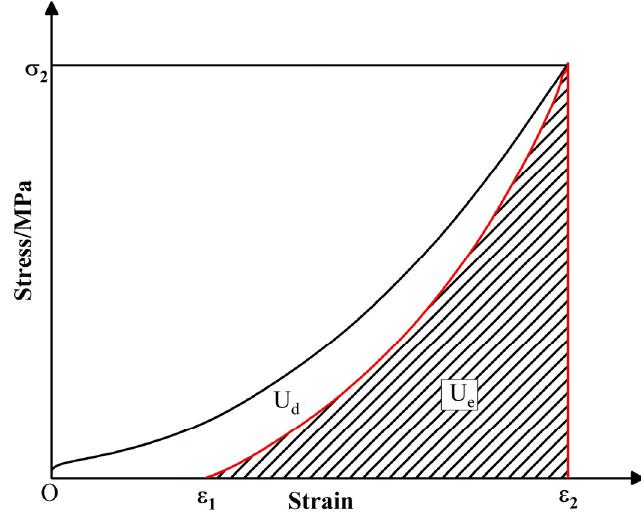
Figure 6. Rock energy density value relationship diagram.